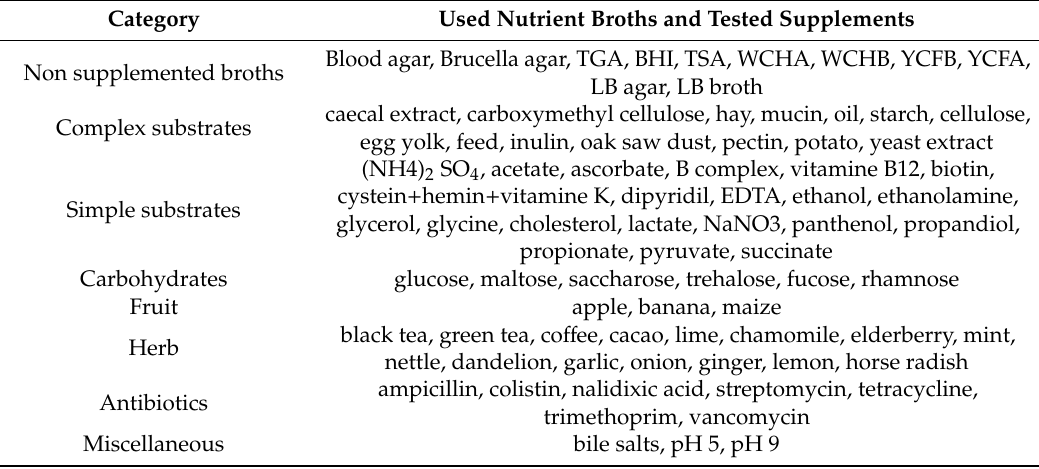
Table 1. List of nutrient media and supplements tested in this